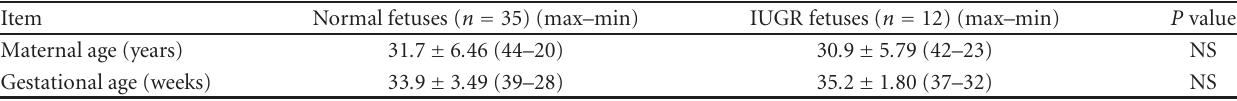
Table 1: Descriptive characteristics of normal and intrauterine growth restricted (IUGR) fetuses.